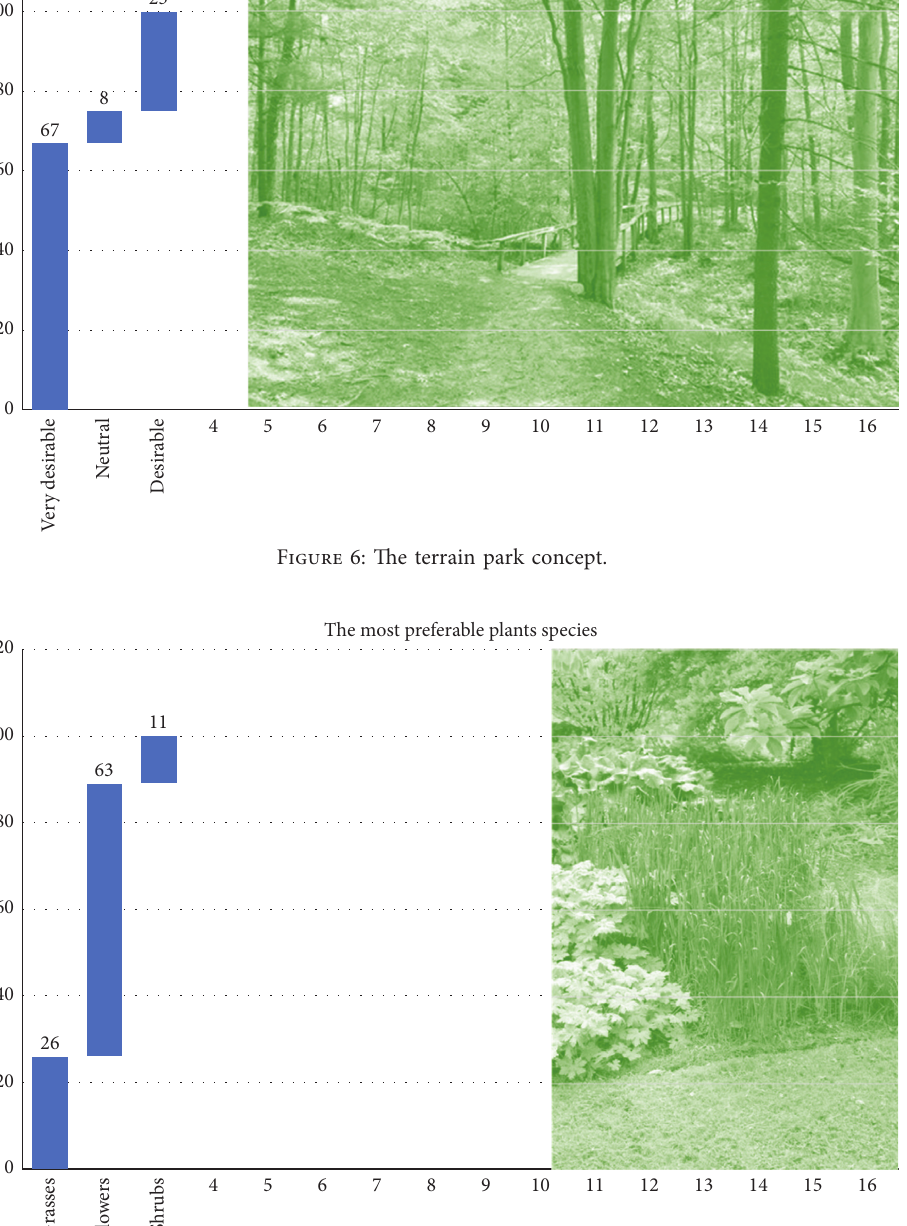
Figure 7: The most preferable plants